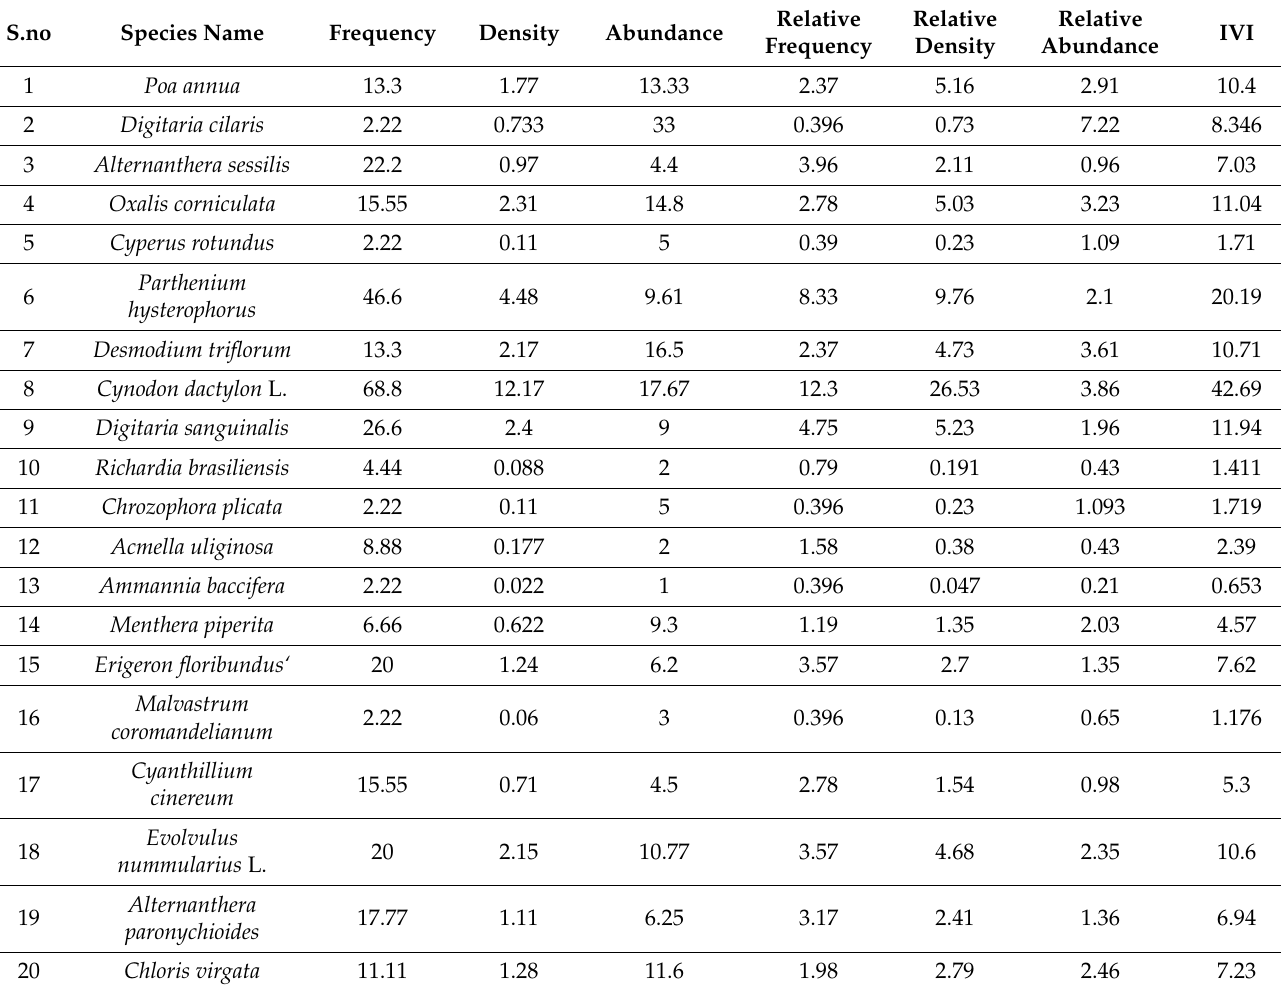
Table 1. Calculation for herbaceous species from the GGV campus